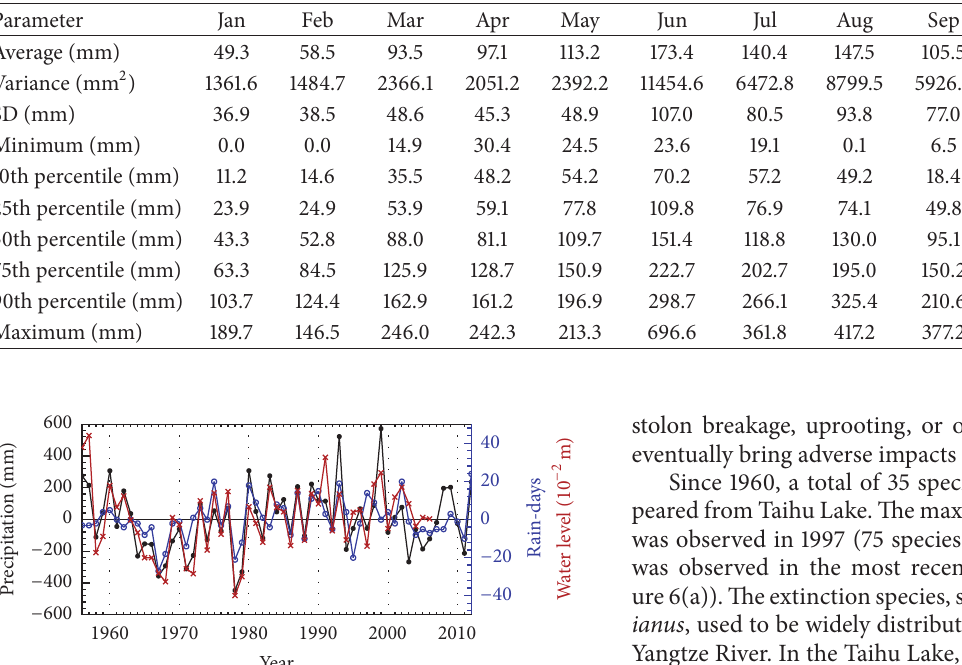
Table 2: Statistical summary of monthly rainfall data at Dongshan (1956–2012).